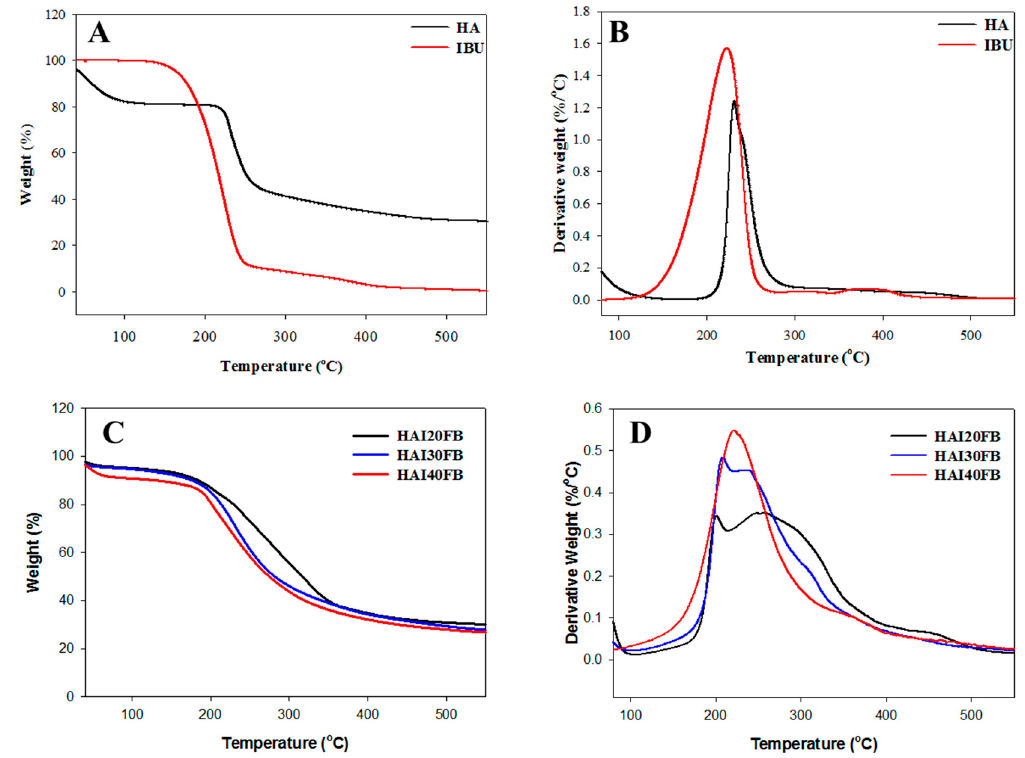
Figure 2. The TGA ( A , C ) and DTG ( B , D ) curves of hyaluronic acid (HA) and ibuprofen (IBU) ( A , B ) and HAI20FB, HAI30FB and HAI40FB NFMs ( C , D ).